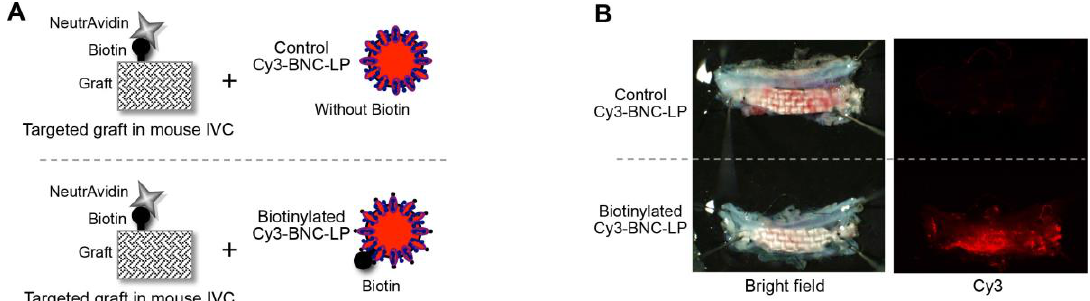
Figure 5. Accumulation of the target-recognizing BNC-LP complex on the targeted graft in mouse blood vessels. ( A ) Schematic diagram of the experiment: the biotinylated BNC-LP complex is compared to the non-biotinylated control. ( B , left) Bright field images show the grafts excised from mice after the in vivo binding assay. (Right) Fluorescence images show the accumulation of biotinylated Cy3-labeled BNC-LP (red) on the graft.